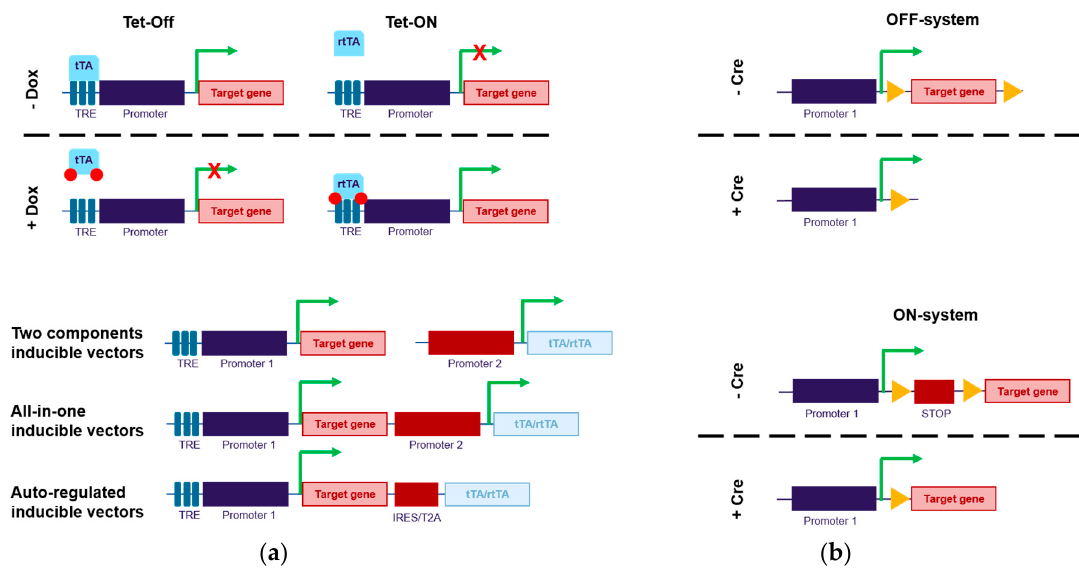
Figure 1. Externally inducible promoter principle . ( a ) The TET-system. For the tet-ON version, upon addition of doxycycline, the tetracycline controlled trans-activator (tTA) can no longer bind Tet response element (TRE), hence leading to interruption of gene expression, whereas for the tet-OFF version, reverse tetracycline controlled trans-activator (rtTA) is not bound to TRE in absence of doxycycline, which does not allow gene transcription until addition of doxycycline. Several strategies have been tested for implantation of the Tet-system in lentiviral vectors (LVs). Initially, two vectors, one encoding the target gene under the control of a TRE and another encoding the trans-activator or the trans-repressor were used. These two parts were then combined into a single vector. Moving to a step further to reduce background level, the trans-activator/trans-repressor were also placed under the regulation of TRE. ( b ) The LoxP/Cre system. For this system, two versions have also been tested in LVs. The gene of interest can be placed between two LoxP sites. Consequently, upon Cre exposure, it will be excised and hence stop transgene expression. Alternatively, a gene silencing sequence (stop codon, poly(A) signal) is inserted with LoxP sites around, just before the target gene. Consequently, the addition of Cre recombinase will lead to the removal of the stop codon and lead to transgene expression.